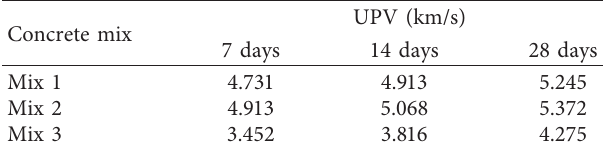
Table 8: UPV values for OPC.